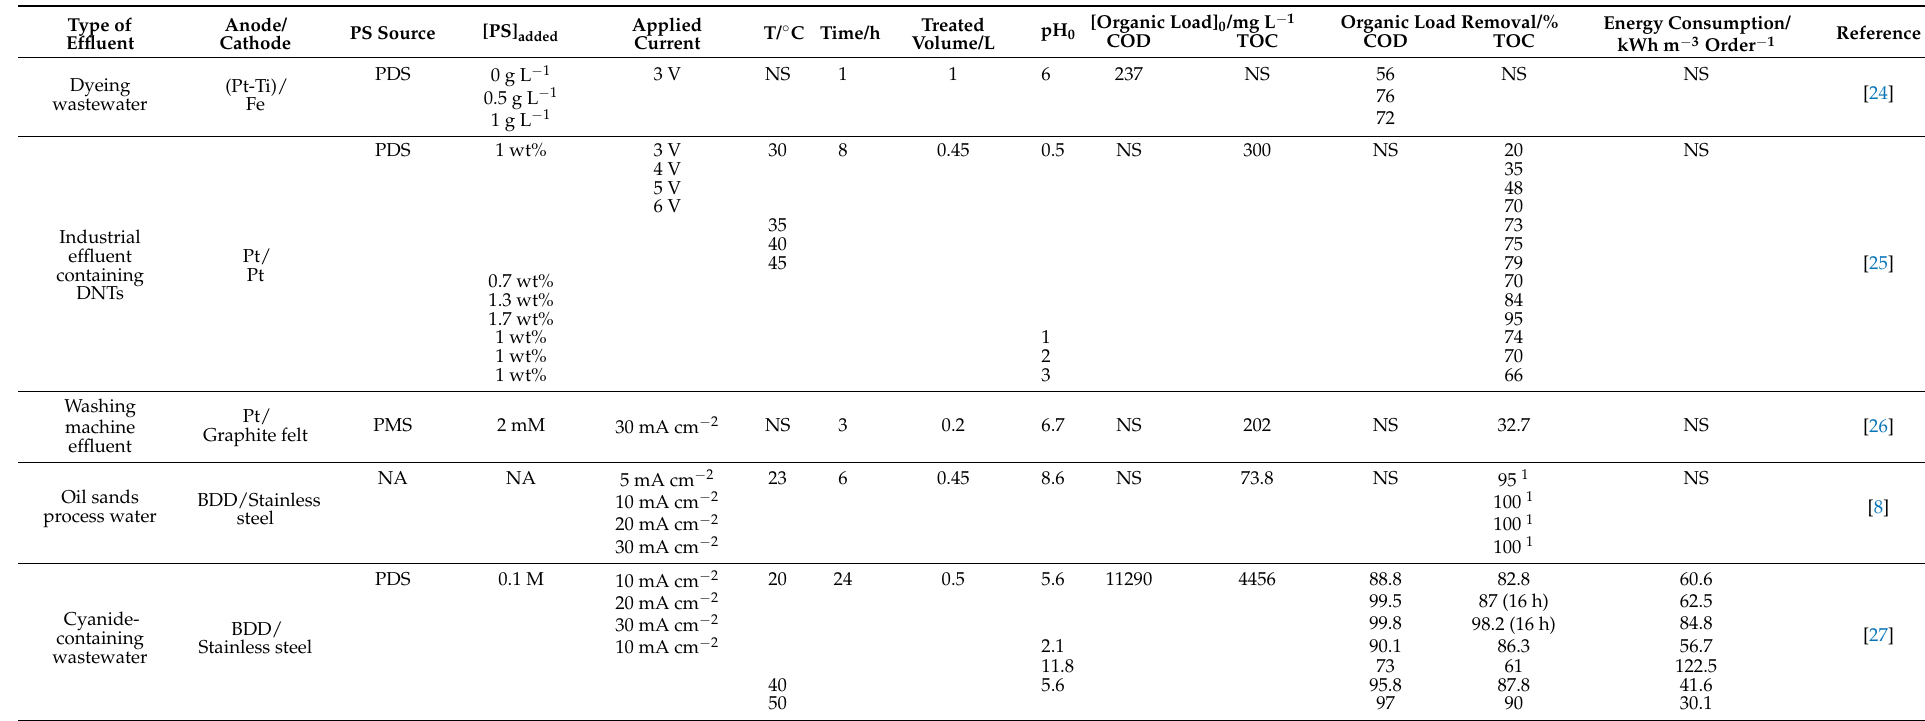
Table 1. Summary of research results previously reported for single electrolytic activation of persulfate in the treatment of complex